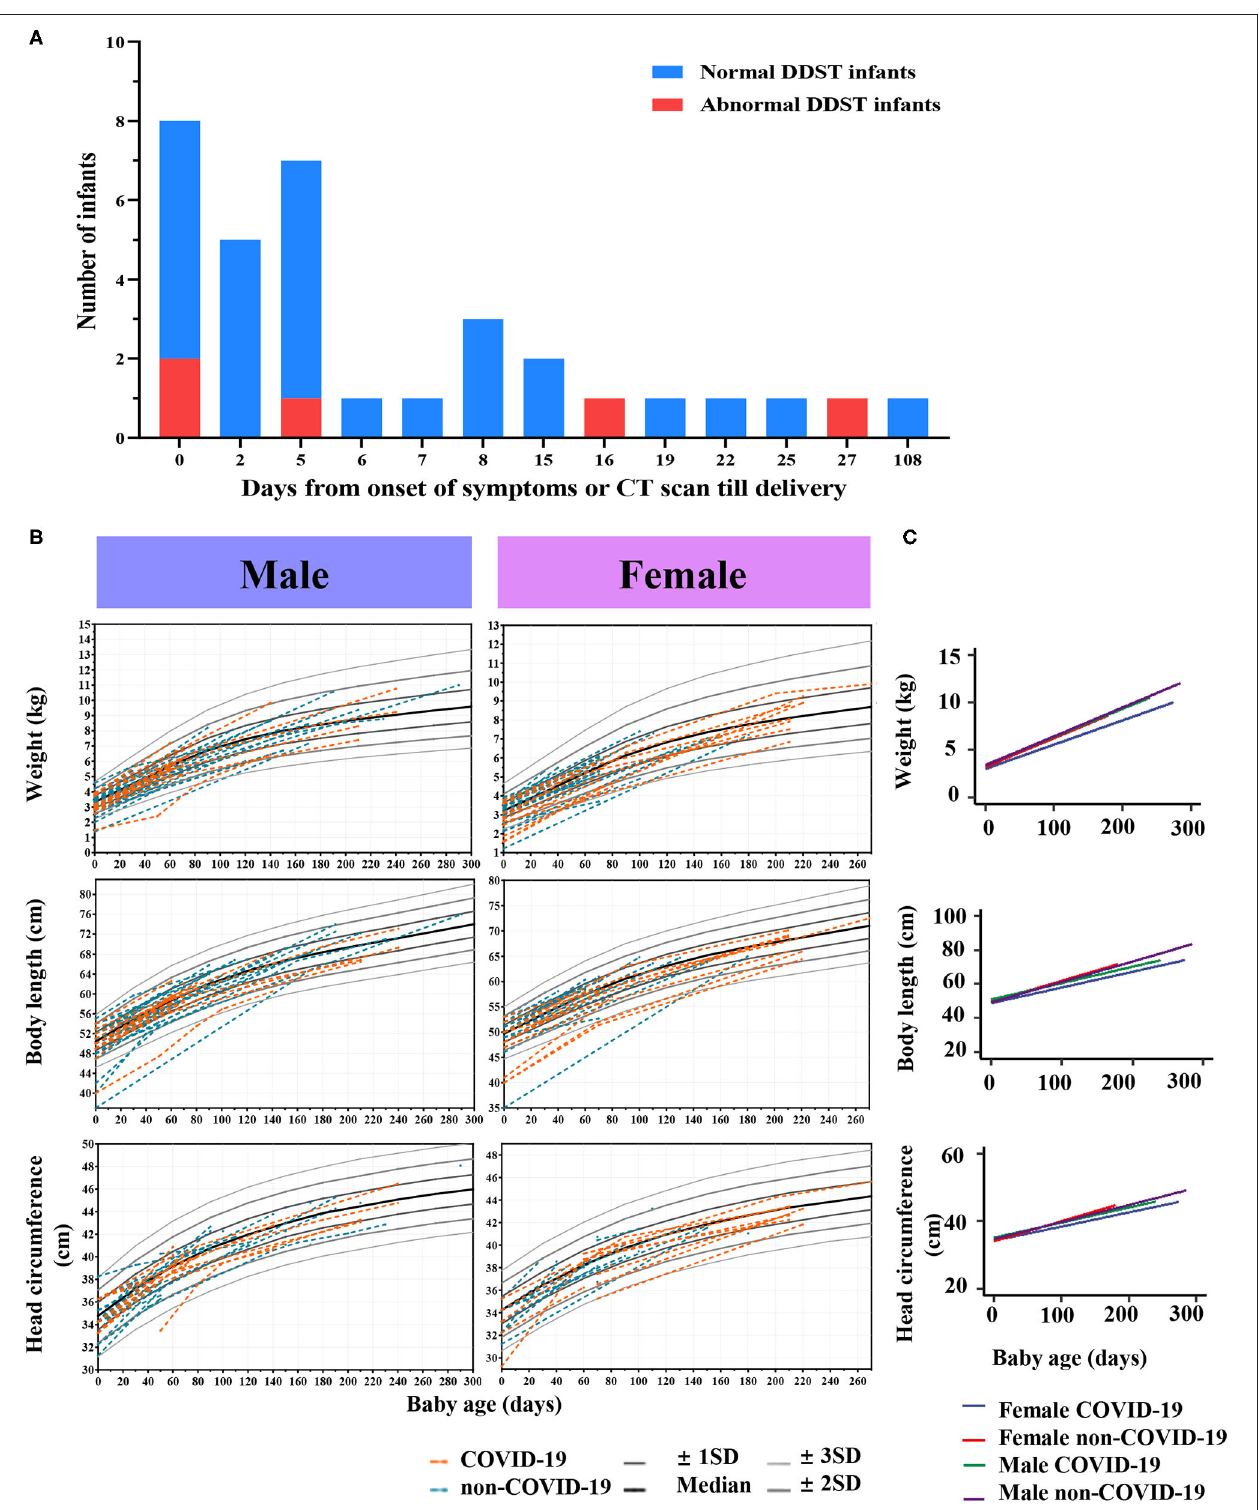
FIGURE 2 | Follow-up outcomes of infants. (A) Distributions of infants with normal or abnormal DDST delivered by COVID-19 mothers. (B) Infants’ growth curves of weight, body length and head circumference in the COVID-19 group and the non-COVID-19 group. (C) Linear mixed-effect models with fixed mean and random intercept were developed to model the within-subject data and determine whether age, sex, and COVID-19 infection status were able to predict the physical development of infants.